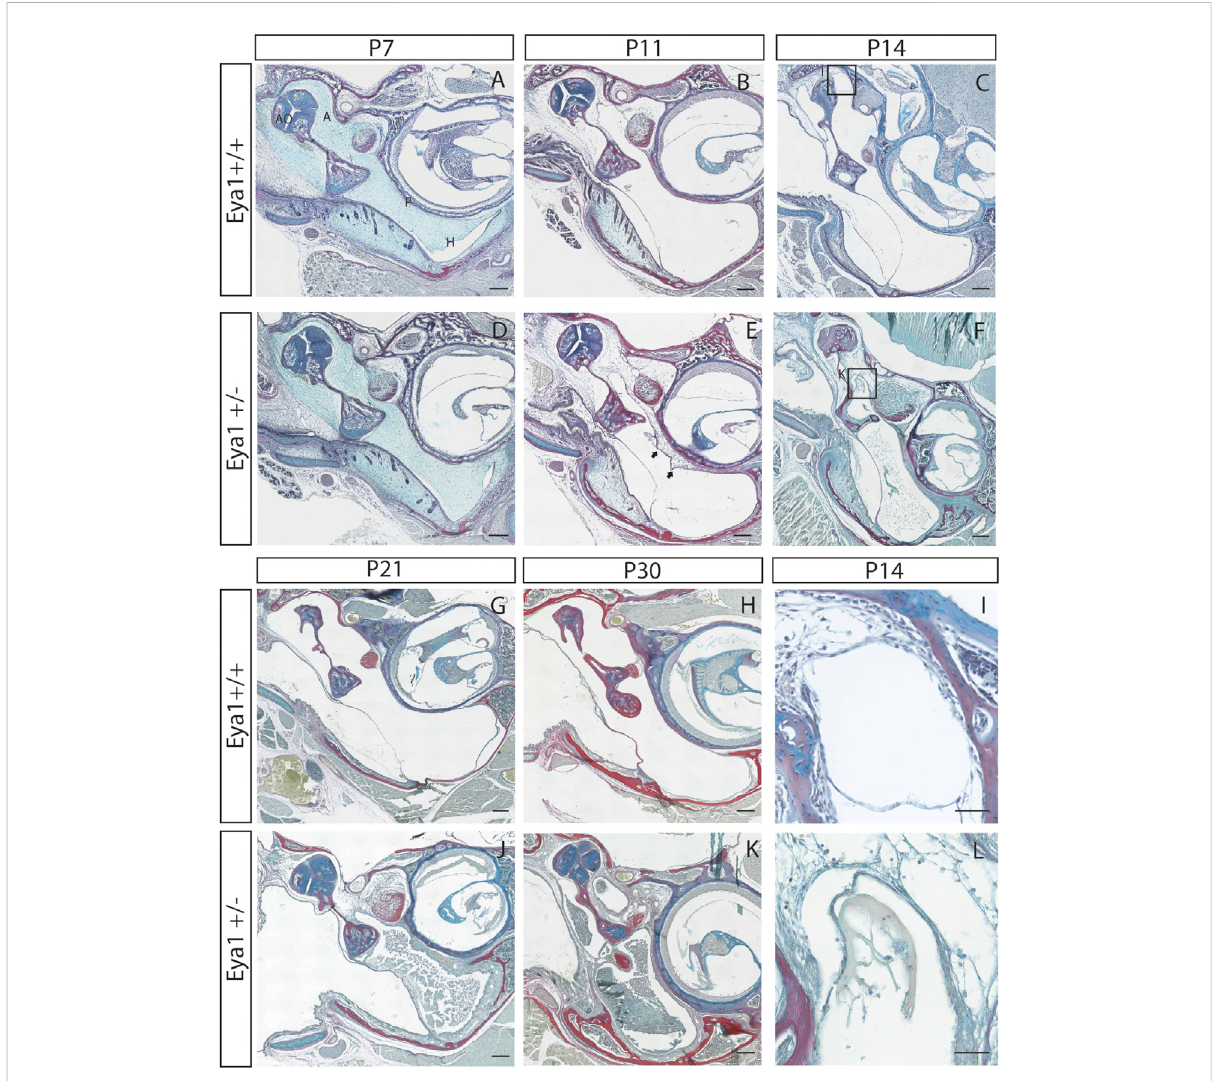
FIGURE 1 Eya1 mice have retained mesenchyme linked to a high incidence of otitis media. Eya1 +/+, (A – C,G – I) Eya1 +/ − (D – F,J – L) frontal trichrome- stained sections of the middle ear. (A,D) There is apotential slight delay in cavitation already evident at P7. (B,E) By P11 retained mesenchyme can be observed on the promontory of the middle ear in Eya1+/ − mice [arrows in (E) ], which is not present in wild-type mice at this stage. (C) In wild-type mice the middle ear has almost completed cavitation by P14 [highlight area shown in (I) ]. (F) OM is observed in the mutants at P14 with effusion abutting the retained mesenchyme and debris dispersed throughout the middle ear [highlight area shown in (L) ]. (G,H,J,K) Disease progresses in the mice as they age, characterized by thickened epithelium along the hypotympanum and build-up of exudate in Hets (J,K) . Juveniles shown are 30 days old (H,K) . [A, attic; P, promontory; H, hypotympanum. Scale bars in (A – H,J,K) set to 200 µm, scale bars in (I,L) set to 50